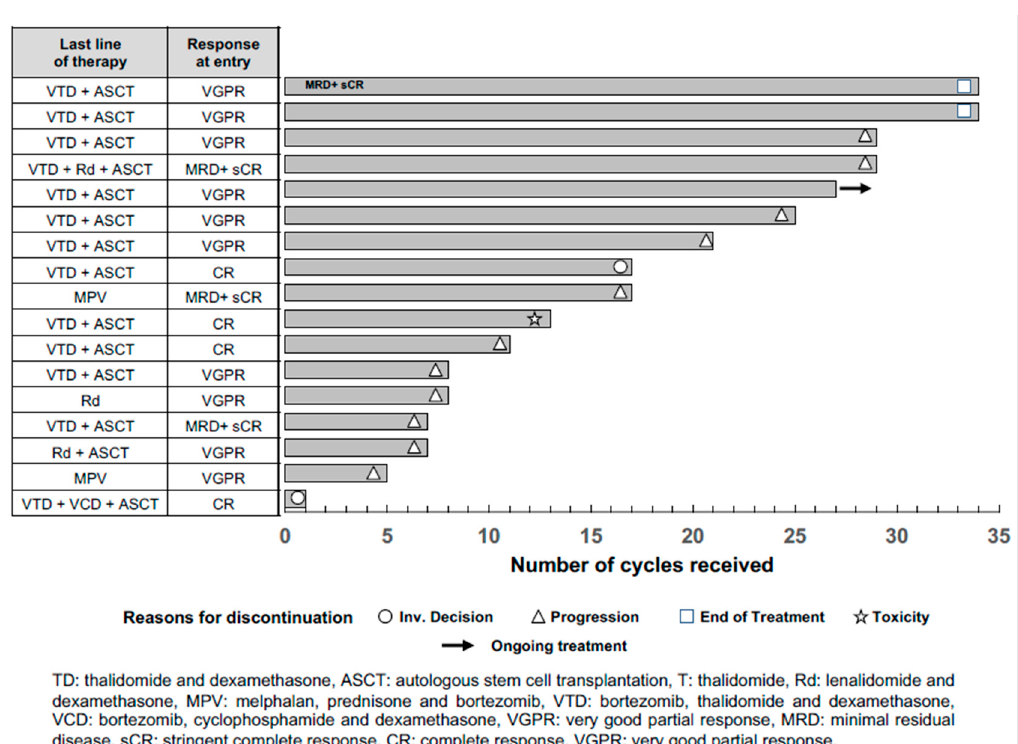
Figure 1. Clinical evolution of the 17 patients included in the study and evaluable for efficacy. Response at study entry, last line of therapy, and, when applicable, the prior line of treatment. Reasons for treatment discontinuation are depicted with specific symbols at the end of each patient’s representing bar.